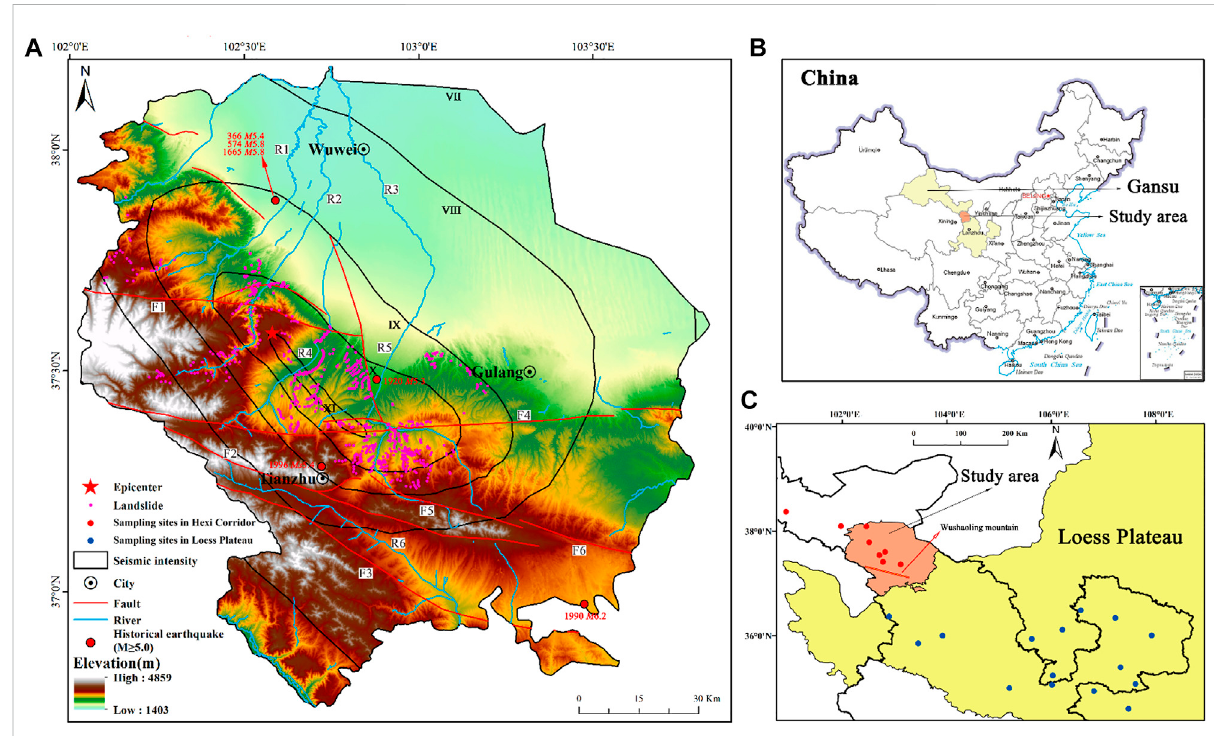
FIGURE 1 Location of the study area, sampling sites, and landslides: (A) Distribution map of landslides triggered by the 1927 Gulang earthquake; (B) location of the study area in China; and (C) the spatial distribution of sampling sites. F1: Huangcheng – Shuangta fault; F2: Jinqianghe fault; F3: Mayaxueshan fault; F4: Tianqiaogou – Huangyangchuan fault; F5: Maomaoshan fault; F6: Laohushan fault; R1: Xiying river; R2: Zamu river; R3: Hongshui river; R4: Huangyang river; R5: Gulang river; R6: Zhuanglang